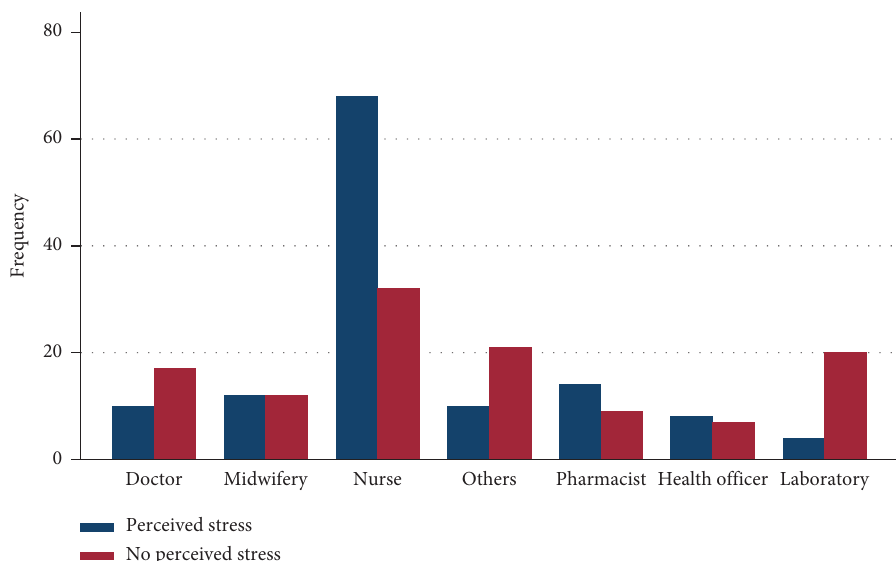
Figure 1: Perceived stress among healthcare providers of Dilla governmental health institutions, Southern Ethiopia, 2020.